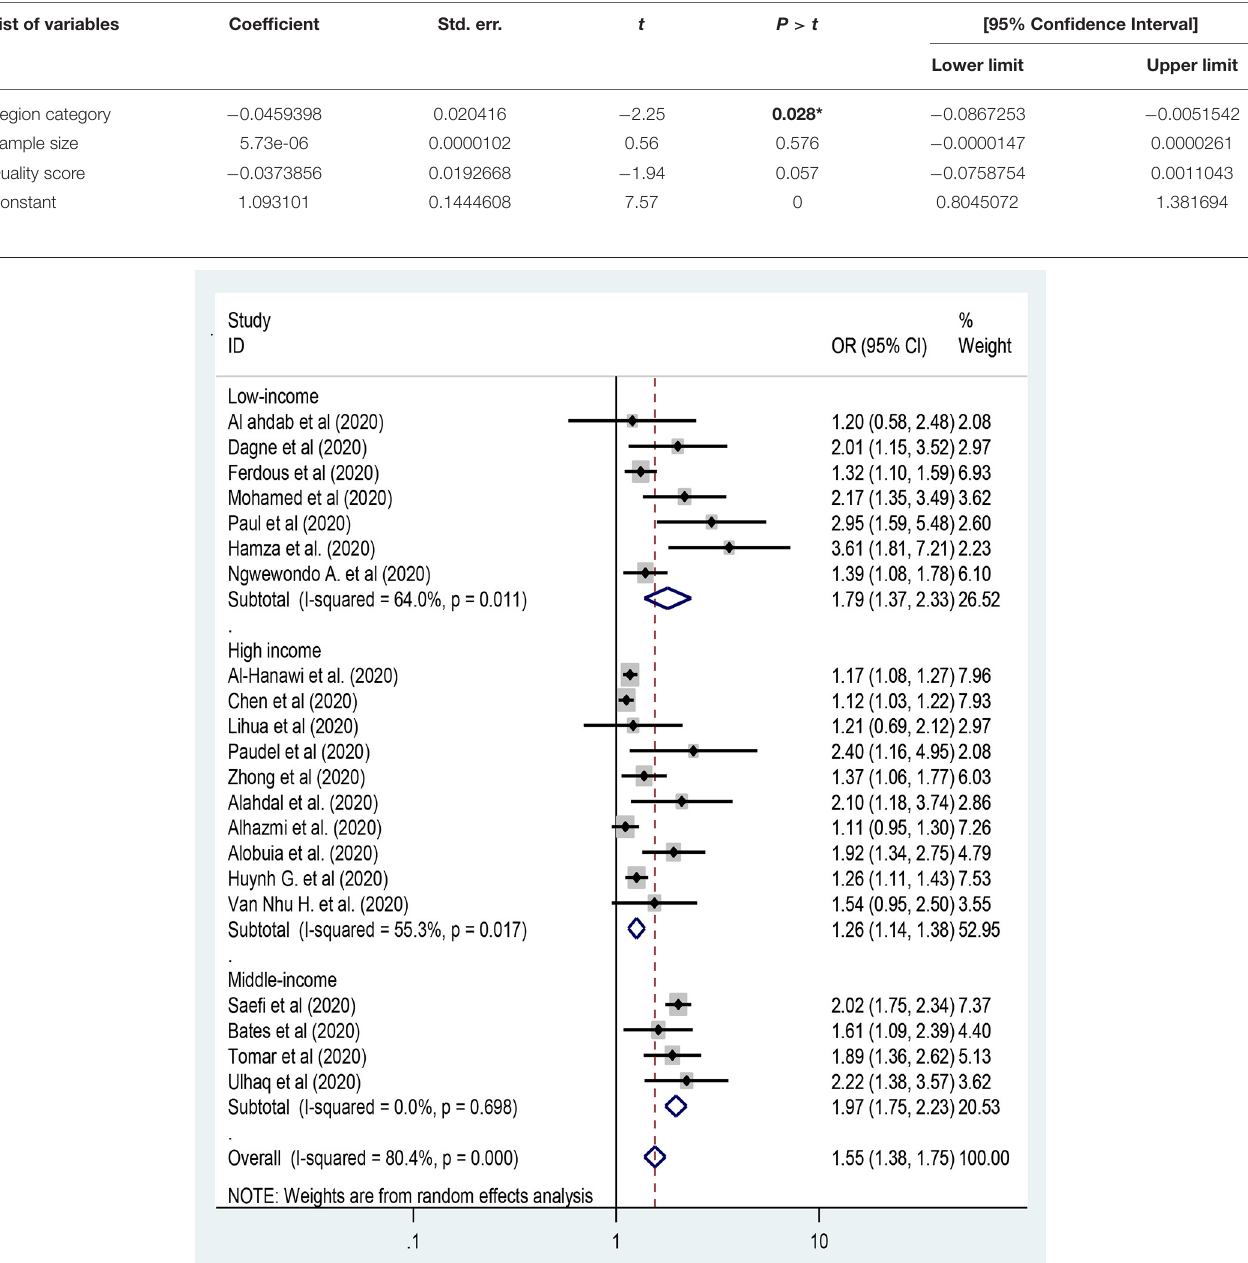
TABLE 1 | Meta regression to identify variables for heterogeneity between studies.